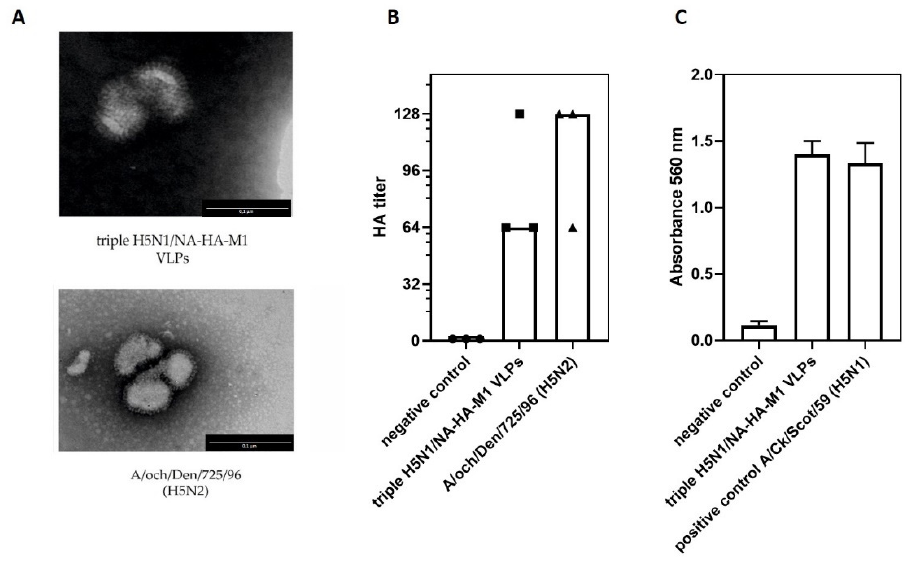
Figure 2. Characterization of H5N1 avian influenza virus triple H5N1/NA-HA-M1 VLPs. ( A ) Transmission electron microscopy of triple H5N1/NA-HA-M1 VLPs and influenza A/H5N2 virus. Scale bar = 1 µ m is shown in the right bottom corner of the images. ( B ) Hemagglutination assay. The AIV A/ostrich/Denmark/725/96 (H5N2) was used as a positive control. The HA titer was determined as the reciprocal of the highest dilution with HA activity. Each dot represents HA titers obtained in each experiment. The bars represent the median values of obtained HA titers. ( C ) Neuraminidase activity assay. The AIV A/Ck/Scot/59 (H5N1) was used as a positive control. For each assay, the mean value from three independent experiments performed is presented. The mean A560 values and standard deviations are shown on the y-axis.